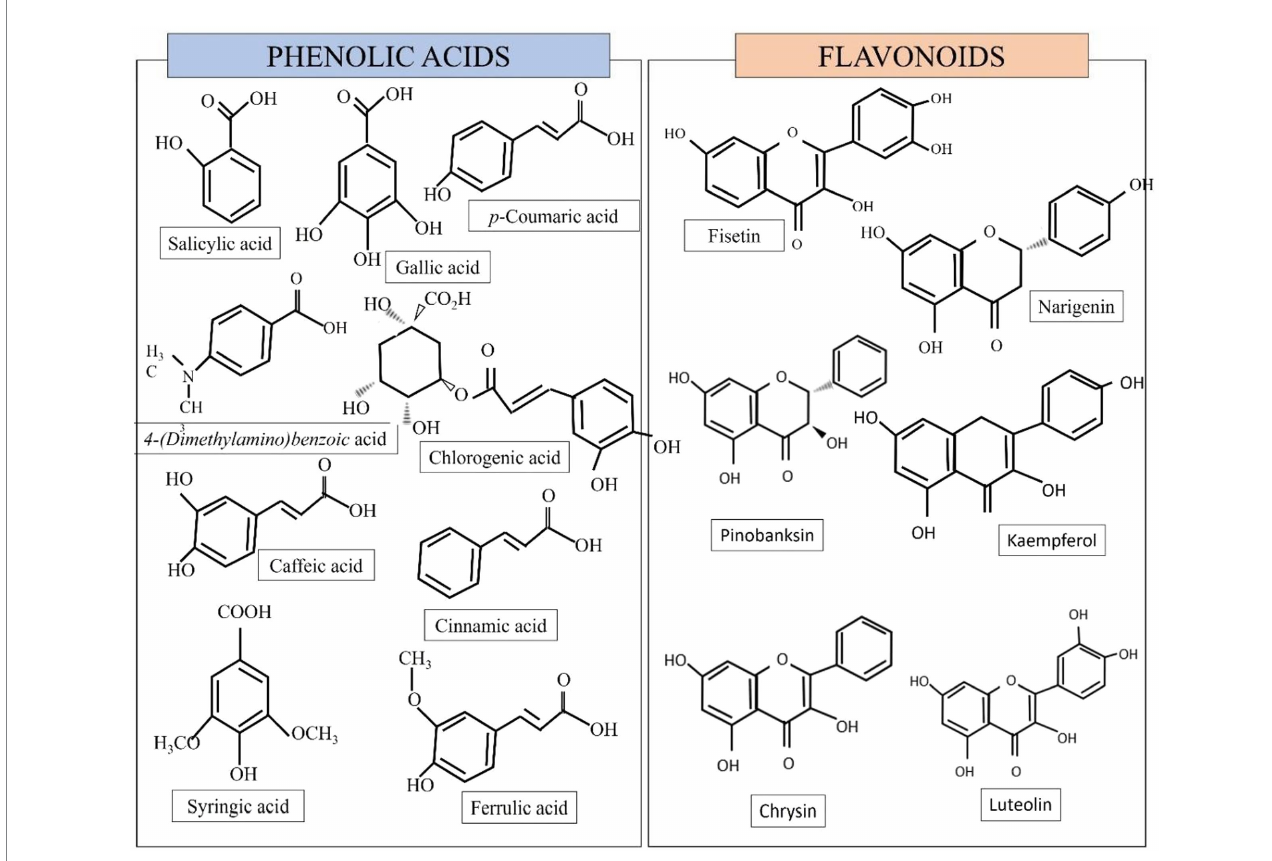
FIGURE 1 Some of the phenolic and flavonoid compounds found in honey (Biluca et al., 2017; Azman et al.,